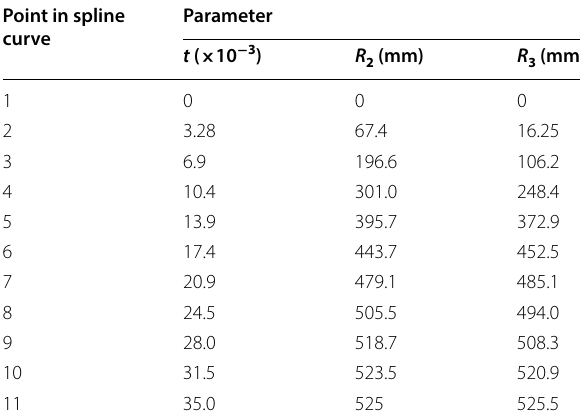
Table 2 The coordinate data for R Point in spline curve